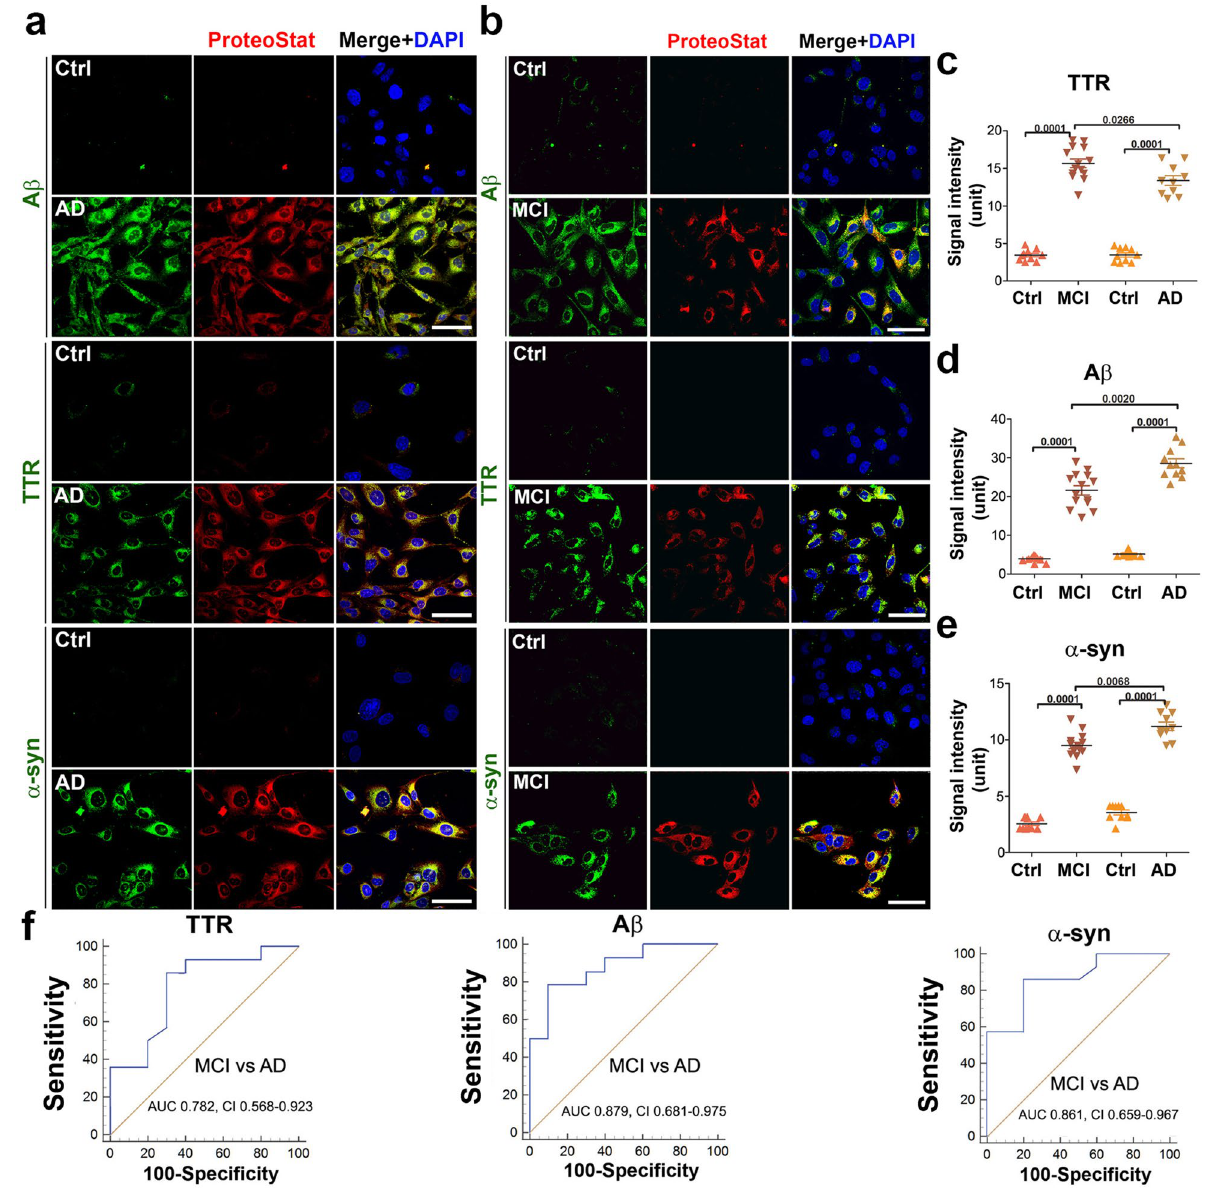
Figure 5. Identification of Aβ, TTR and α-synuclein as the components of the aggregates accumulated in ADTs treated with sera from AD or MCI. ( a , b ) Representative images show colocalization of TTR, Aβ or α-synuclein (α-syn) (green) with ProteoStat signal (red). ADTs were treated with 10% sera from AD (n = 10), MCI (n = 14) or control (n = 19), fixed at 24 h, immunostained with antibodies against Aβ, TTR or α-syn and then co-stained with ProteoStat dye. The nuclei were stained with DAPI (blue). Bar: 50 µm. ( c ) The fluorescence intensity of TTR, Aβ and α-syn in A and B was measured and statistically compared among groups. ( d ) ROC analyses show robust difference in TTR, Aβ and α-syn between the samples from MCI (n = 14) and AD (n = 10) patients. Data are expressed as mean ± SEM and analyzed by one-way